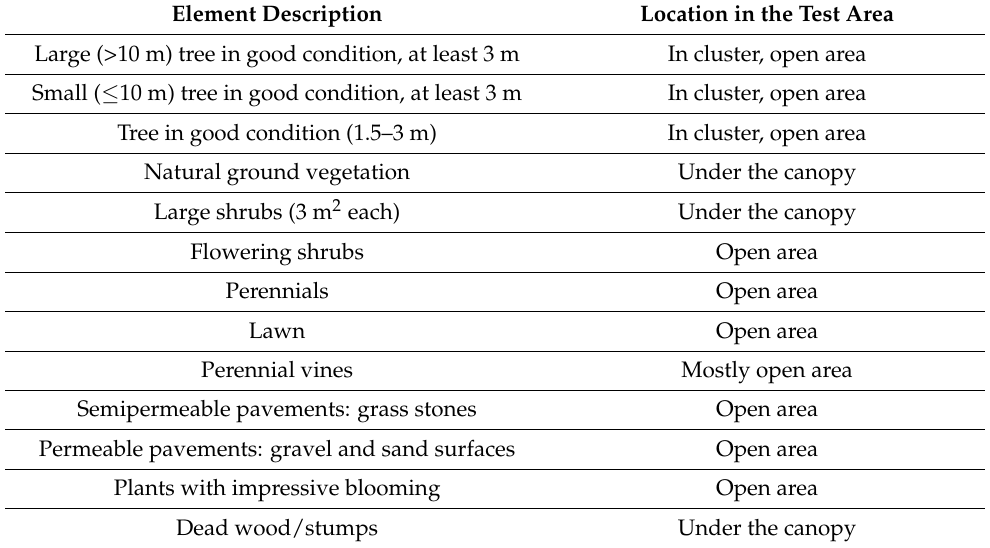
Table 1. Tested green factor elements according to, and adapted from, the Helsinki green factor tool. Element Description